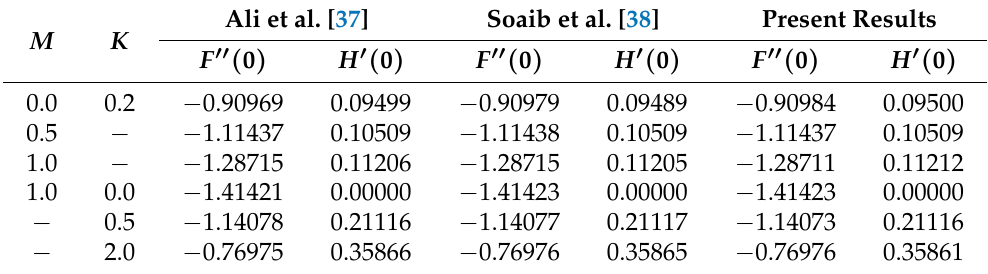
Table 2. H (cid:48) ( 0 ) & F (cid:48)(cid:48) ( 0 ) against K & M , when α = a = λ = Ω = 0.